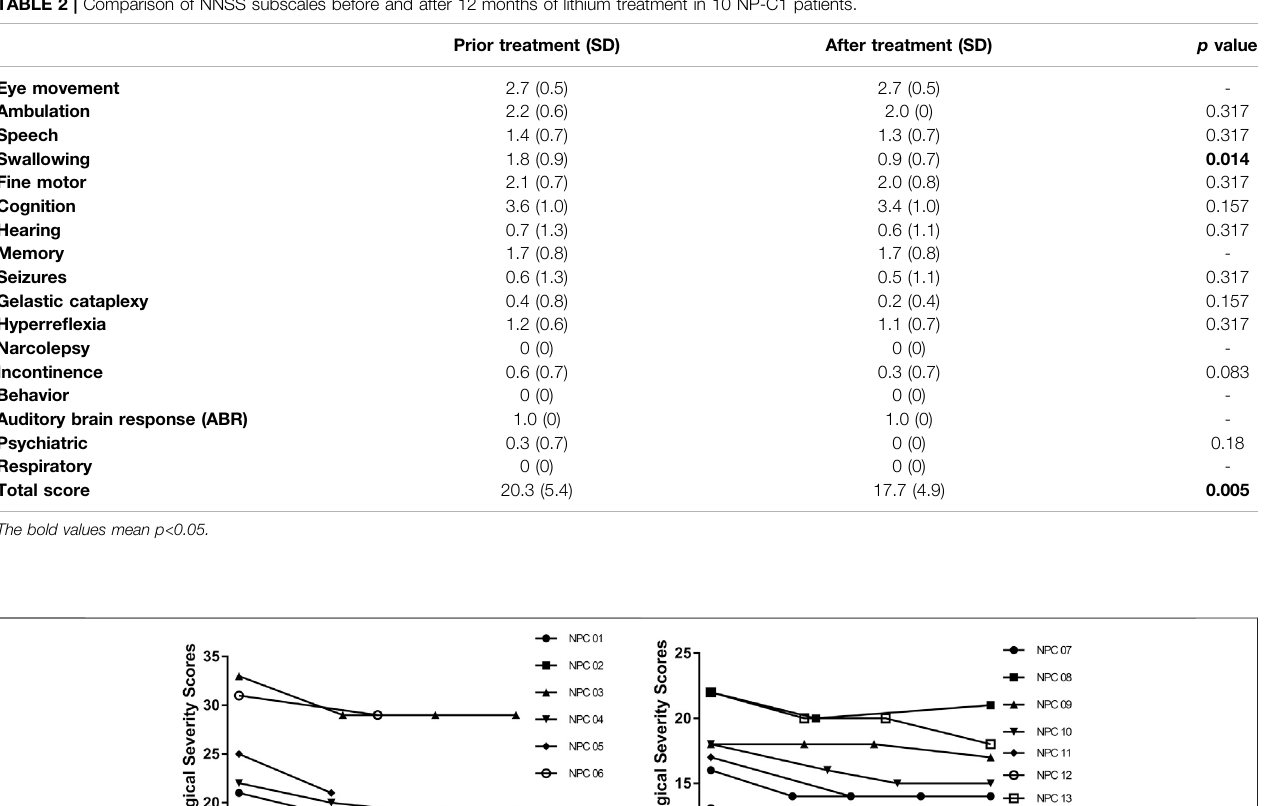
TABLE 2 | Comparison of NNSS subscales before and after 12 months of lithium treatment in 10 NP-C1 patients. Prior treatment (SD) After treatment (SD) p value Eye movement